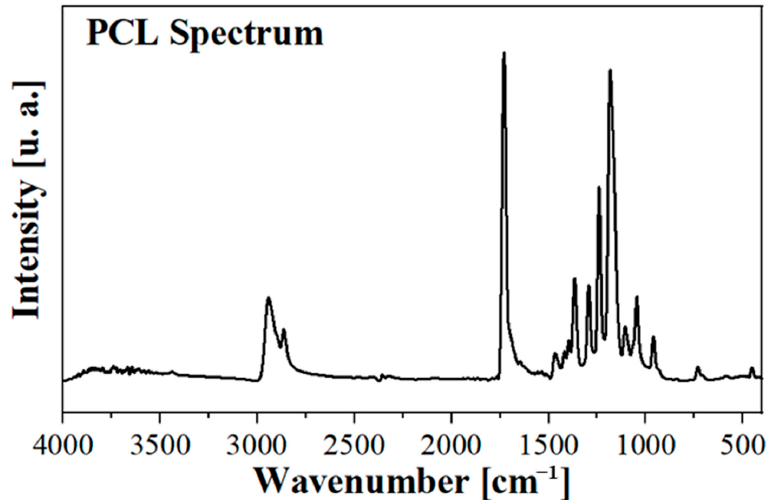
Figure 3. FTIR Spectrum of the PCL membrane.